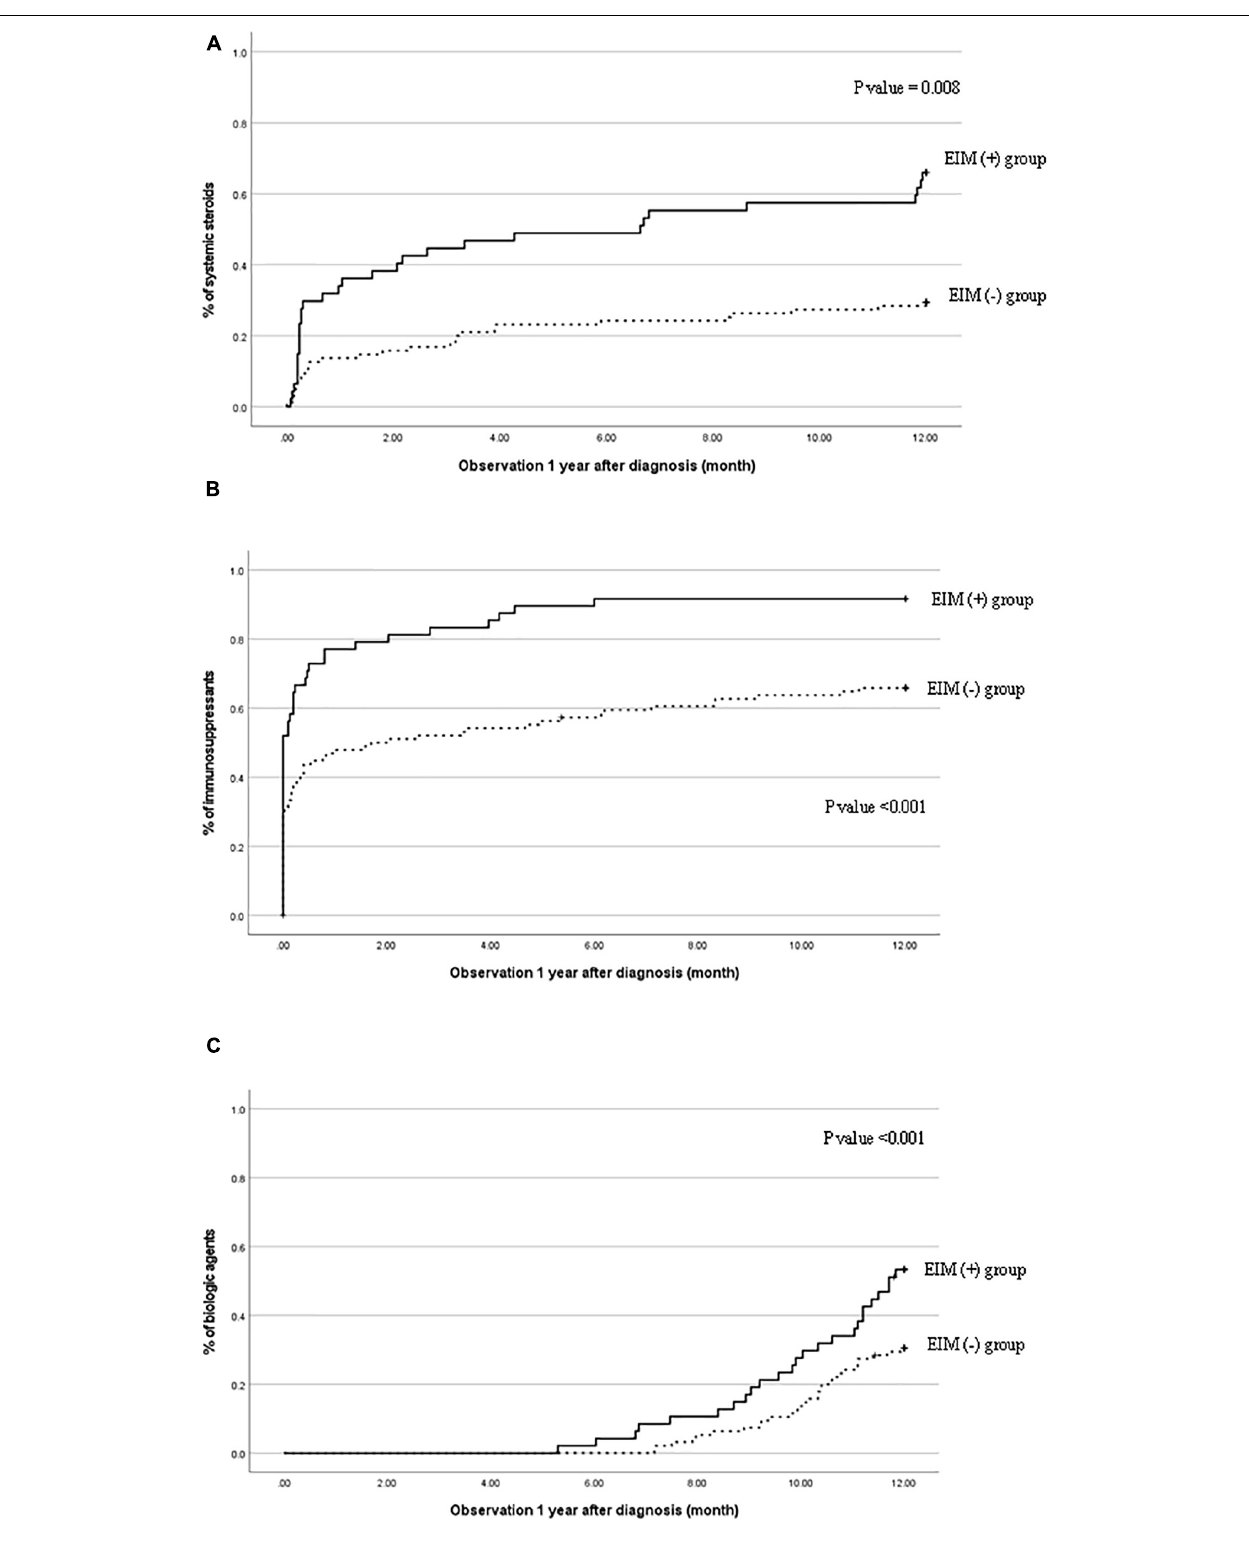
Frontiers in Pediatrics |